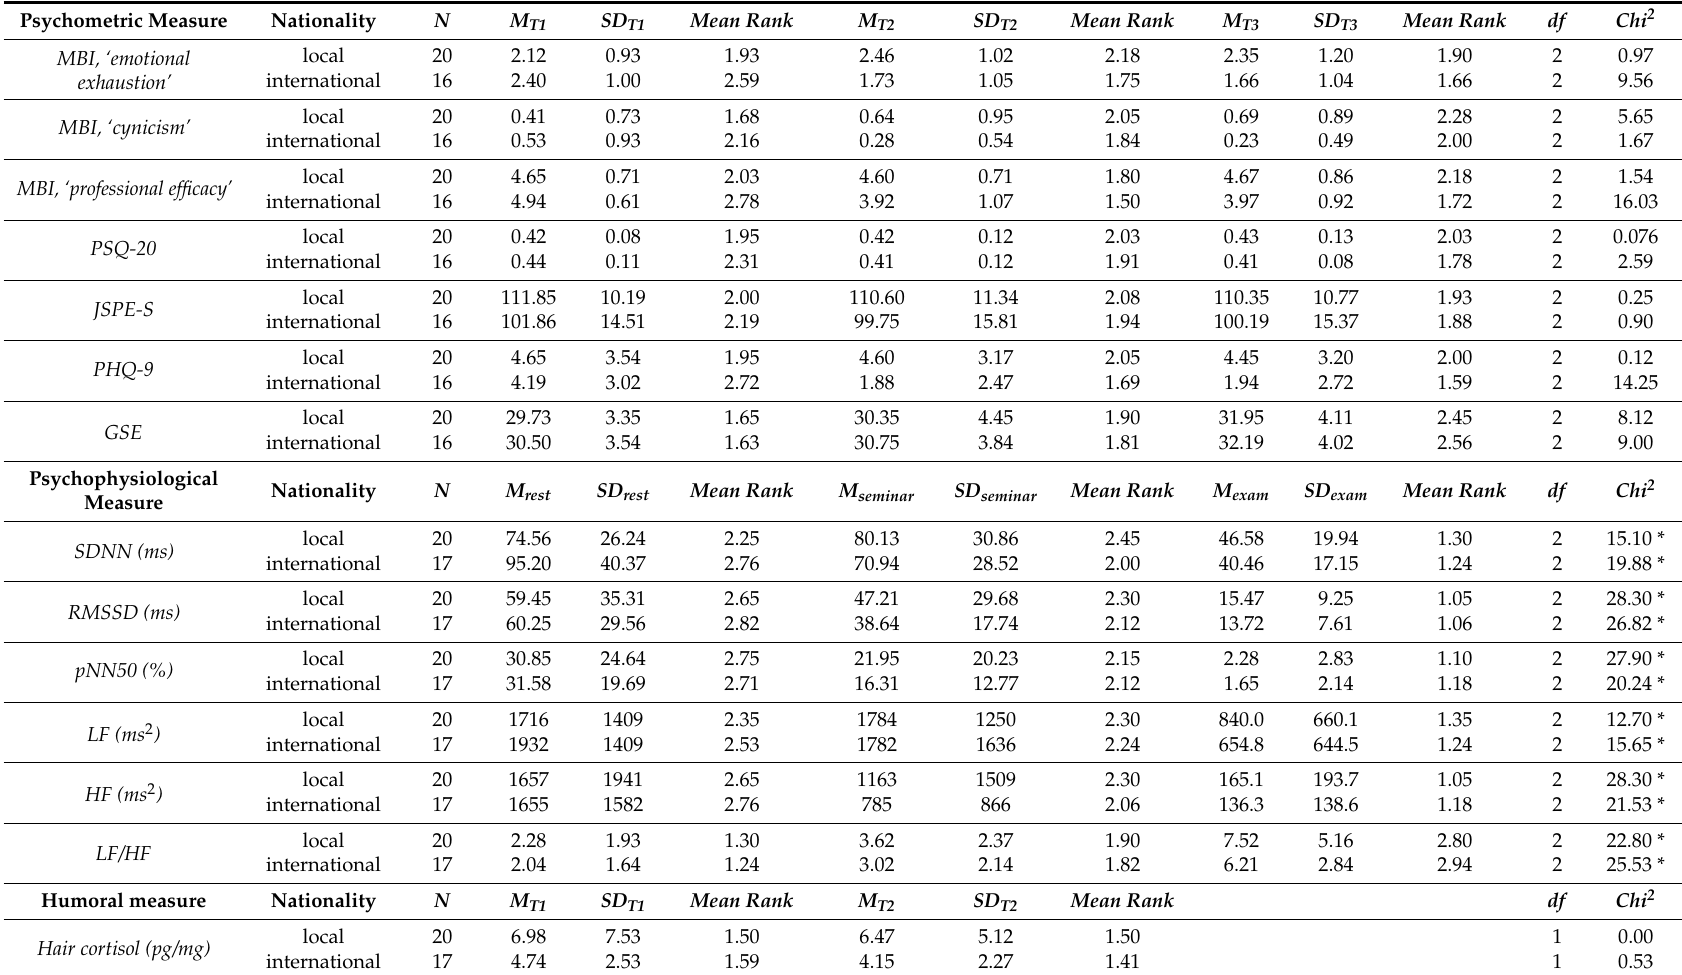
Table 3. The Friedman Test for changes over the course of the